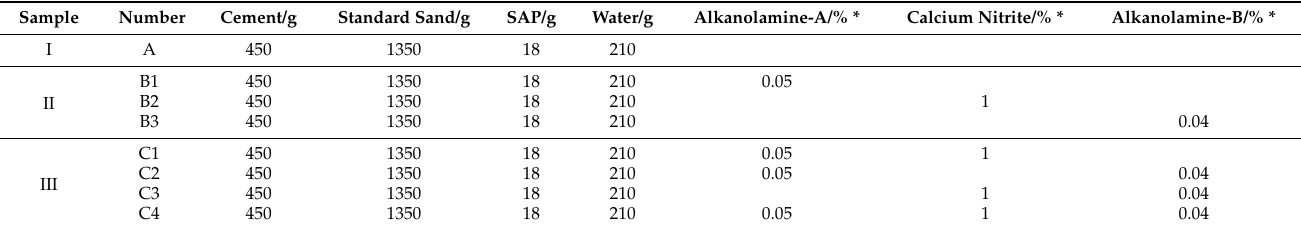
Table 3. Mortar mix proportion